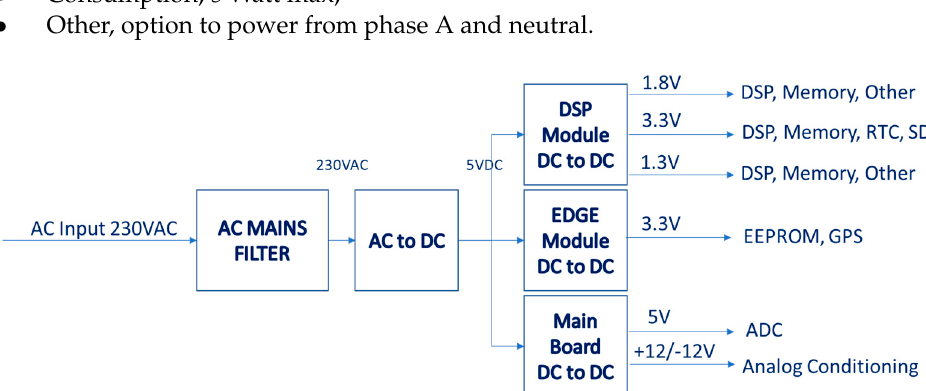
Figure 8. High − level architecture of the power supply module.